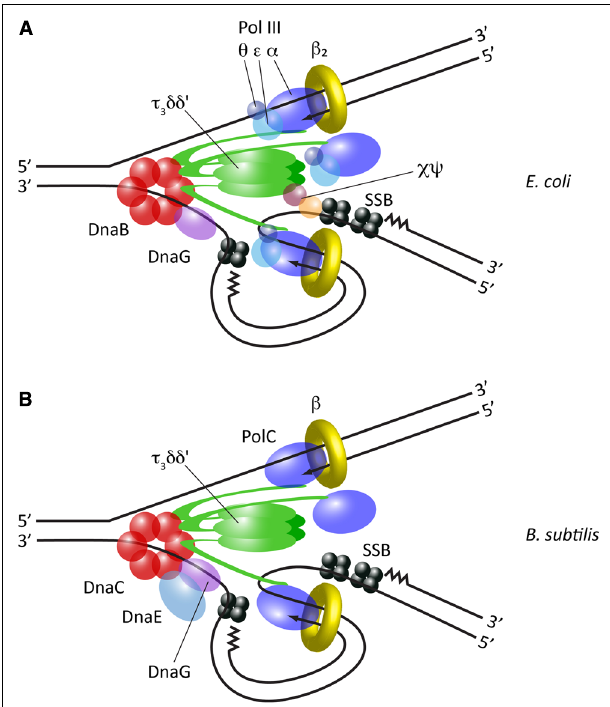
FIGURE 1 | Replisome architecture in bacteria. (A) Architecture of the E. coli replisome, derived from in vitro studies and direct observation in vivo . (B) Architecture of the B. subtilis replisome, predominantly derived from in vitro reconstitution